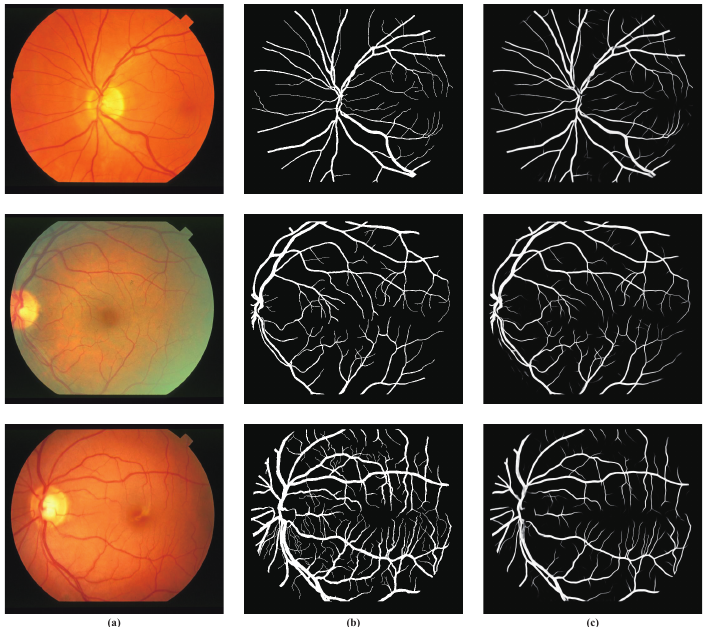
Figure 6. Experimental outputs for the STARE dataset using our method ( a ) Image; ( b ) ground truth; ( c ) our